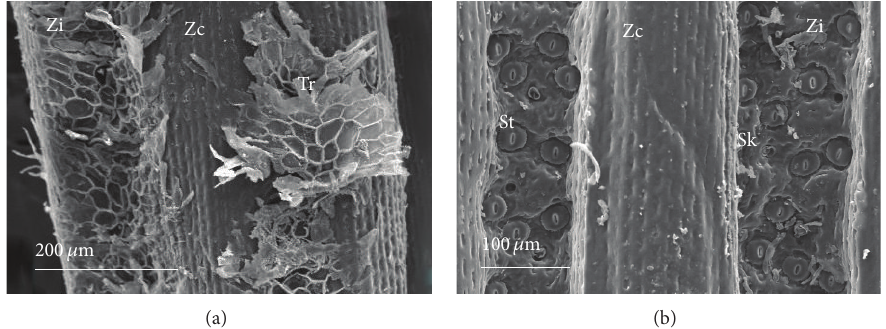
Figure 2: Abaxial surface frontal view of the leaf blade of Dyckia brevifolia Baker, as observed in scanning electron microscopy. (a) Peltate trichomes (Tr) covering the intercoastal zones (Zi). (b) Stomata (St) in the intercoastal zones (Zi). (Sk = stalk; Zc = coastal zone.)